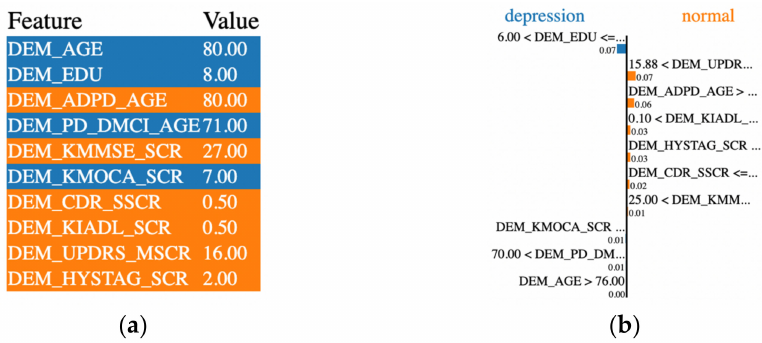
Figure 2. Example of a PD patient with depression